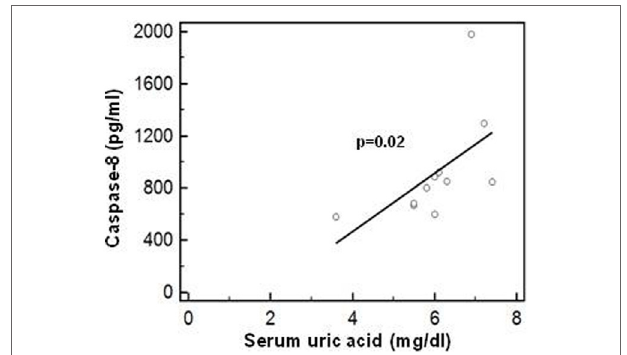
FigUre 9 | Correlation between caspase-8 and uric acid concentration. Correlation between active caspase-8 protein (lipopolysaccharide-primed and monosodium urate crystals-stimulated PBMCs) and serum uric acid concentration in PPMS patients. Statistical significance is